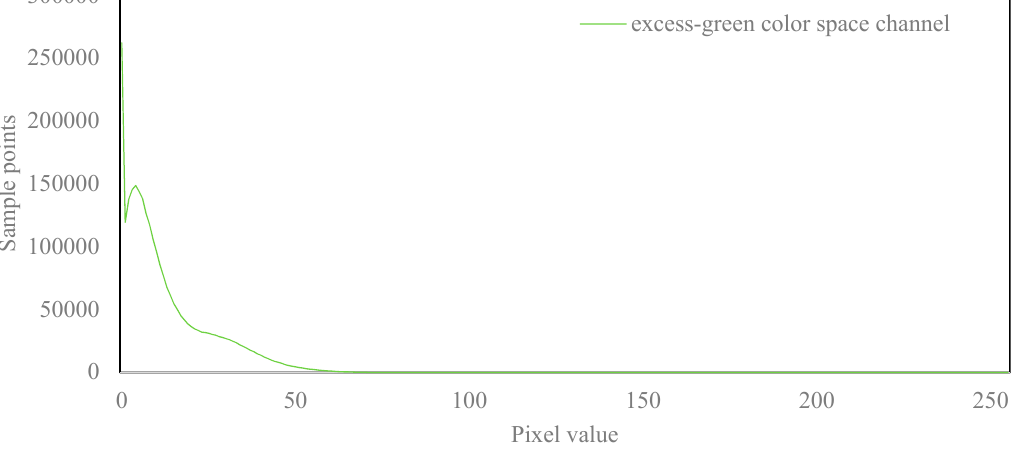
Figure 5. Gray histogram of the cabbage seedling image in the excess green color space.